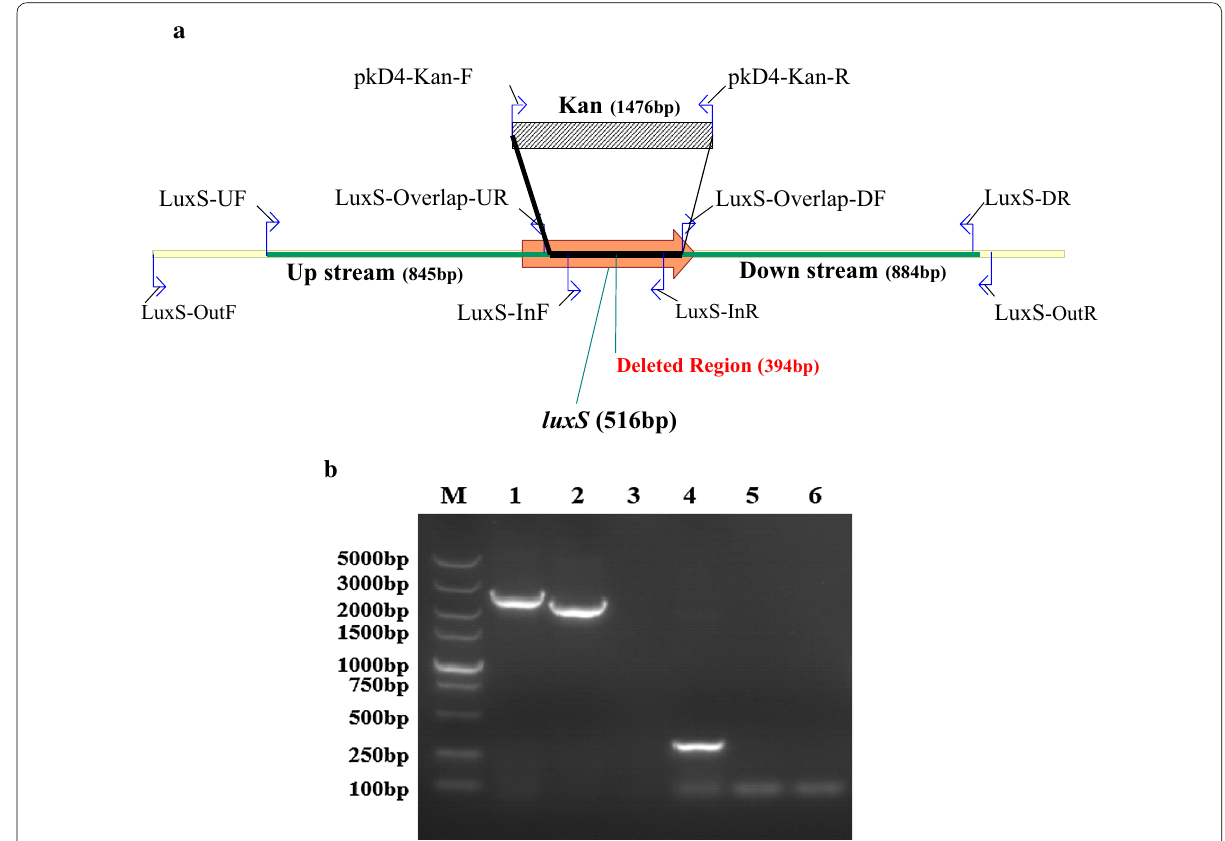
Fig. 1 Identification of the luxS mutant BL21∆ luxS. a Schematic chart of strategy for producing the BL21 luxS deletion mutant. The luxS was deleted by replacing the partial gene sequence of luxS with kanamycin resistance cassette at Sal I cleavage sites. The primers used for the confirmation of the luxS deletion are also indicated. b Identification of the luxS mutant BL21∆ luxS. Lane M: DL 2000 DNA marker (D501A; Takara); lane 1: the wild- type strain BL21 showed a 2519-bp PCR product using primers LuxS-OutF/LuxS-OutR; lane 2: the mutant BL21∆ luxS with cure of the kanamycin resistance cassette showed a 2209-bp PCR product using primers LuxS-OutF/LuxS-OutR; lane 3: negative control; lane 4: the wild-type strain DE17 showed a 307-bp PCR product using primers LuxS-inF/LuxS-inR; lane 5: the mutant DE17∆ pfs showed no PCR products using primers